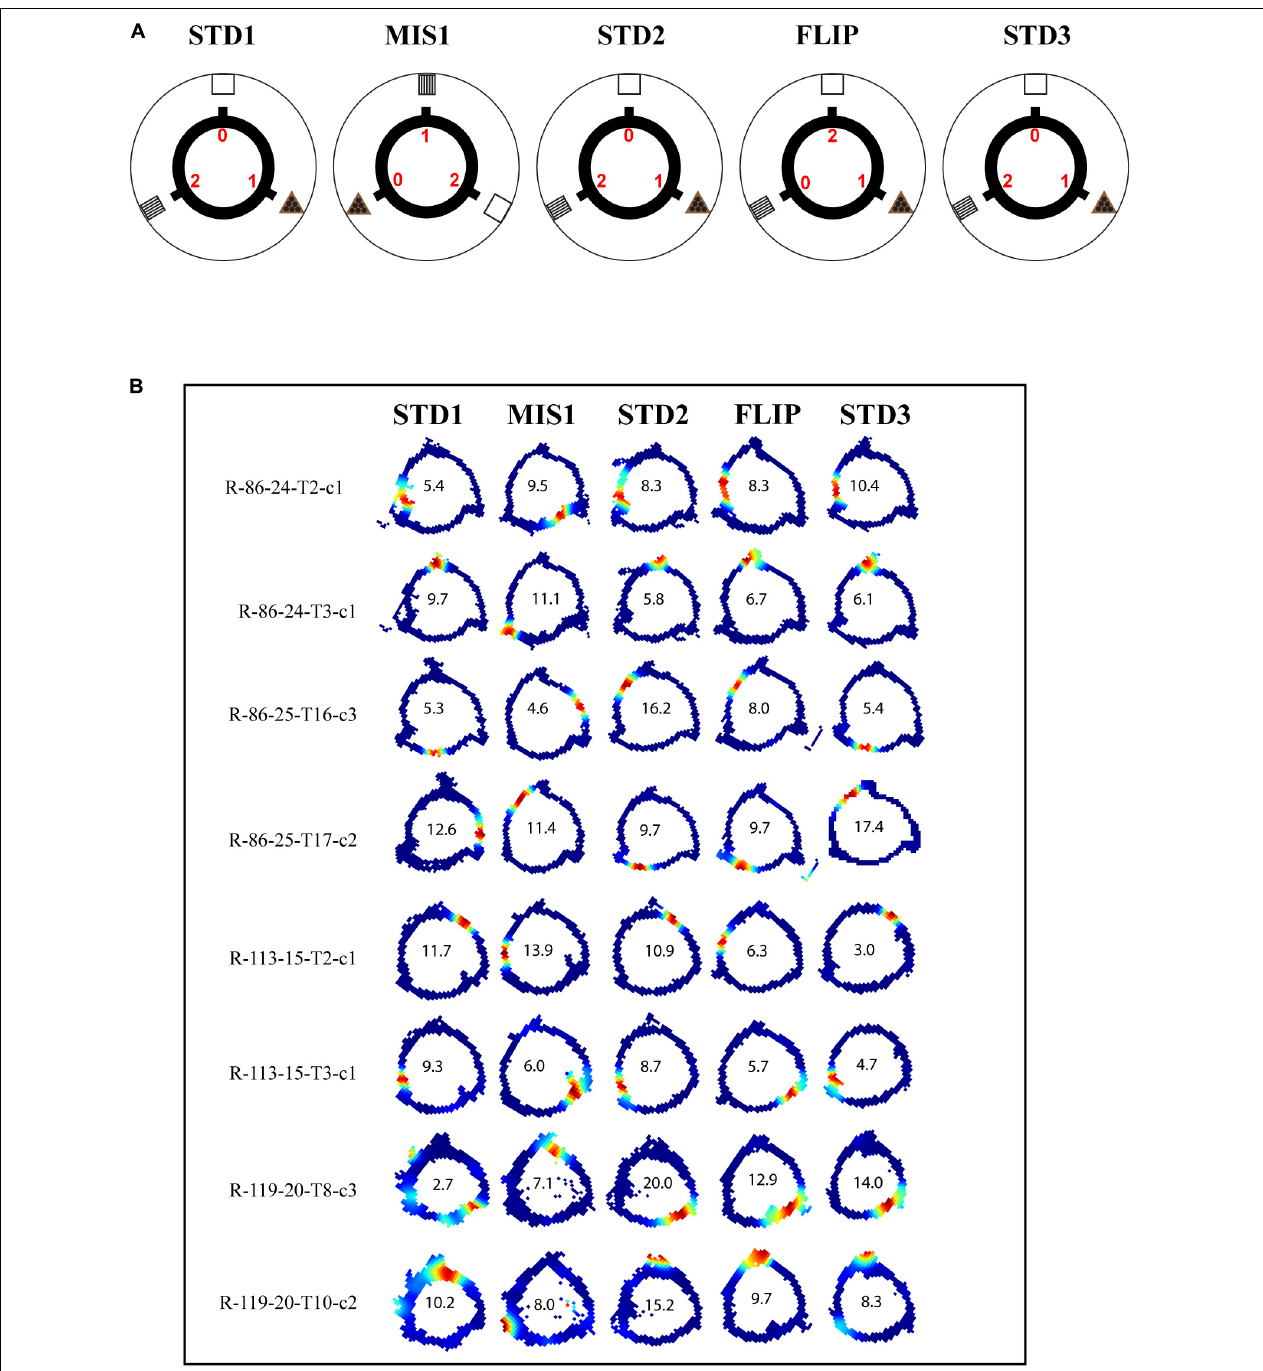
FIGURE 5 | Schematic representation of double rotation experiments with different reward magnitude as local cues (RwdMag). (A) The schematic representation of the RwdMag double-rotation paradigm in which rewards of different magnitude were provided at specific spokes. Colored numbers (0, 1, 2) indicate the number of reward pellets offered at the corresponding spokes. (B) Representative place fields from different experimental days from five sessions. The rate map color coding is the same as described in Figure 2 . The number inside the firing rate maps indicates the peak firing rate in Hz.